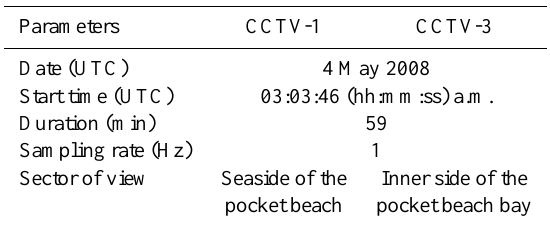
Table 1. Summary of the two video data bursts used in this